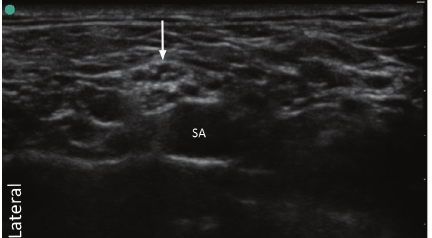
Figure 17: Transverse ultrasound image of supraclavicular brachial plexus. Arrow points toward the divisions of the brachial plexus. The location of the brachial plexus is posterolateral to the subcla- vian artery